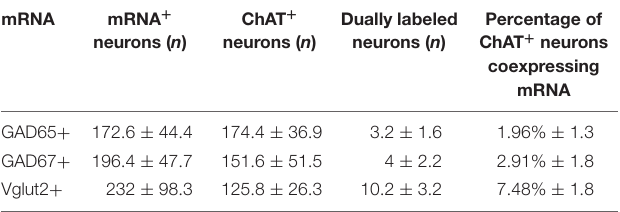
TABLE 4 | Total numbers and percentages of dual ChAT + /mRNA + neurons in the PPN. Dually labeled Percentage of ChAT + mRNA mRNA + neurons ( n ) neurons ( n ) ChAT + neurons ( n )